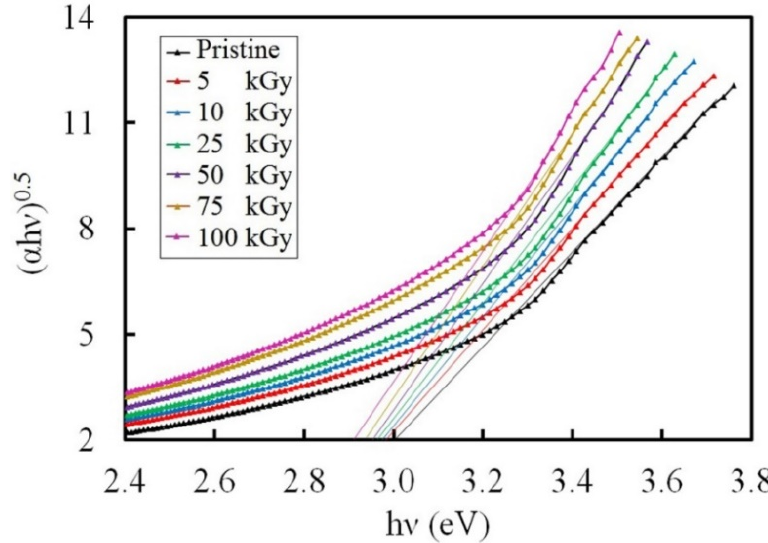
Figure 7. A Plot of ( α h ν ) 0.5 against h ν for the pristine and irradiated NC films.